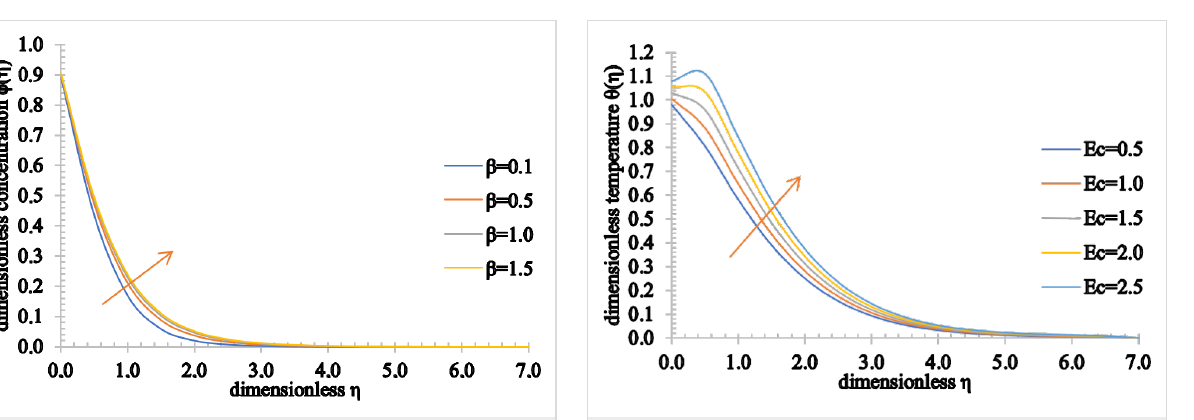
Figure 13: The temperature profile for increasing values of Ec .